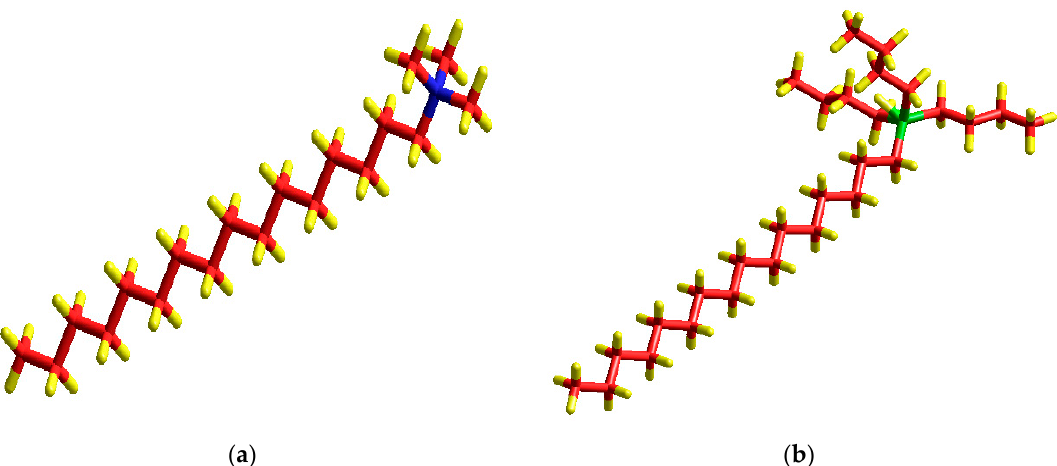
Figure 2. Molecular geometry of the surfactants: ( a ) alkyl ammonium (A) and ( b ) alkyl phosphonium (P). Blue is nitrogen, red is carbon, yellow is hydrogen, and green is phosphorous cylinders.